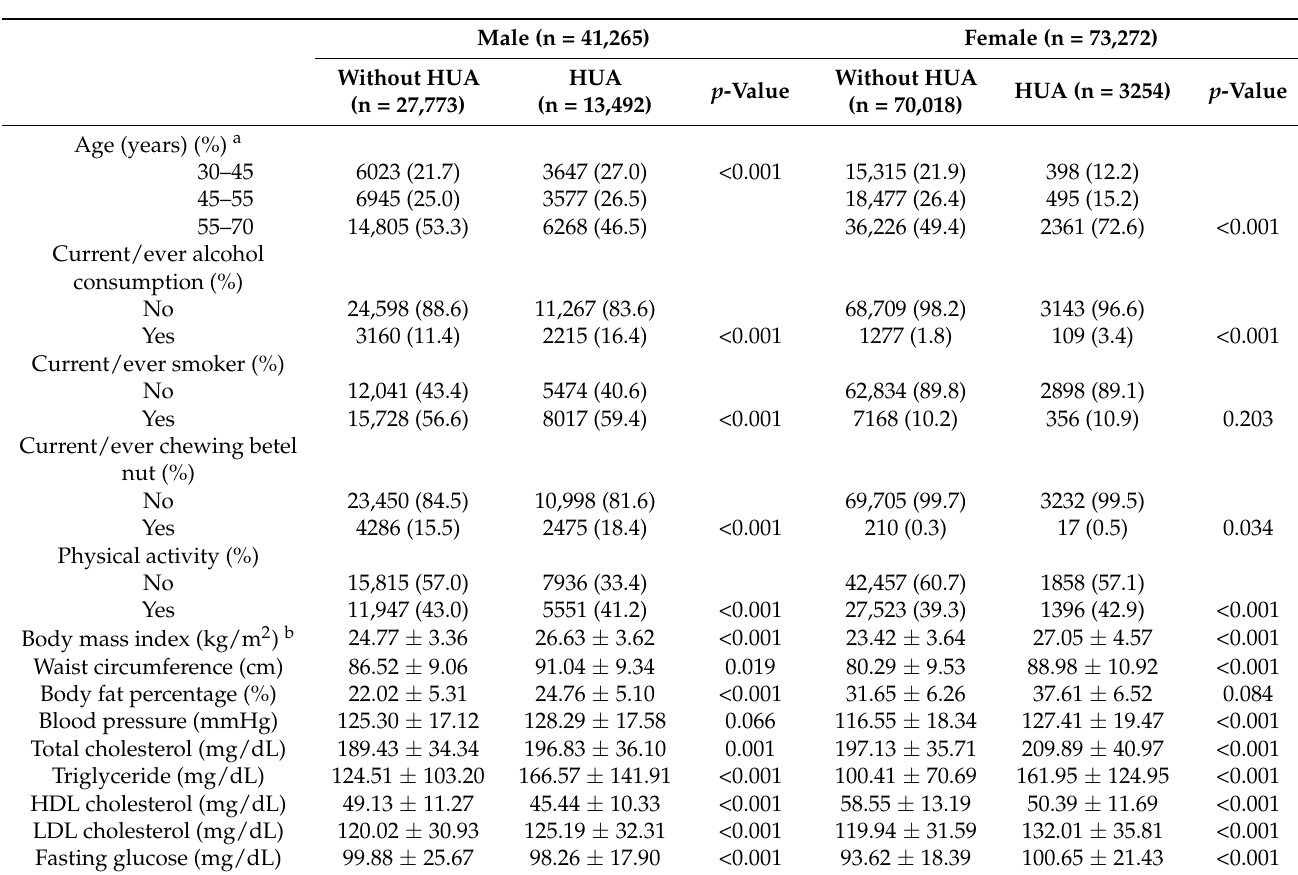
Table 1. Basic characteristics of the